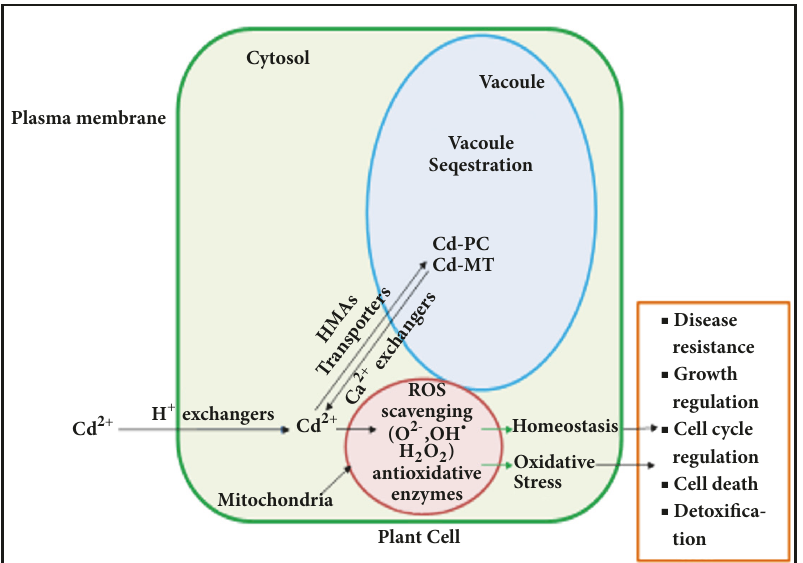
Figure 6: Schematic representation of Cd detoxification in plant cell (heavy metal ATP ases (HMAs), phytochelatins (PC), metallothioneins (MT), and reactive oxygen species